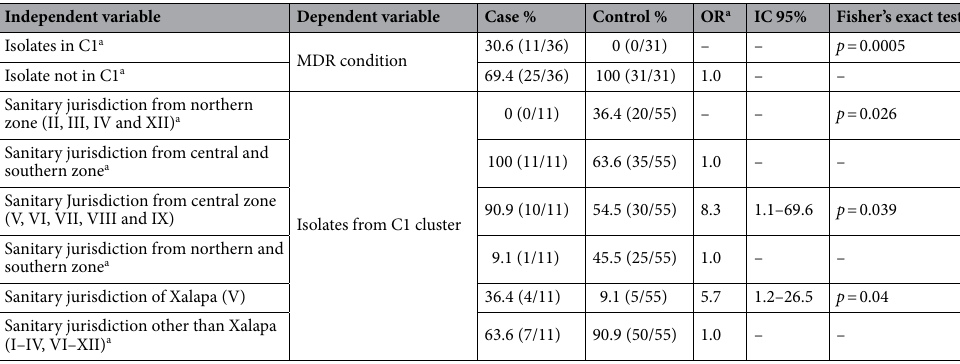
Table 3. Variables with significant association with isolates from the C1 cluster. ** p value < 0.05 was considered significant. a OR calculation was impossible to